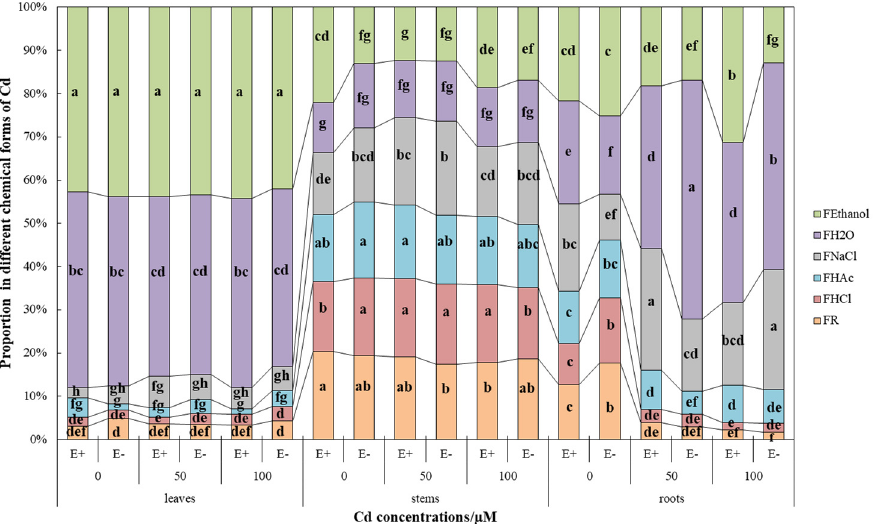
Figure 7. Distribution proportion of different chemical forms of Cd in the leaves, roots, and stems of Hordeum brevisublatum . F Ethanol : 80% ethanol extraction state; F H2O : deionized water extraction state, F NaCl : 1M NaCl extraction state, F HAc : 2% HAc extraction state, F HCl : 0.6 M HCl extraction state and F R : residual state. Lowercase letters (a–h) in the middle of bars indicate significant differences ( p < 0.05) of E+ and E − plants in di ff erent chemical forms under the di ff erent concentrations of CdCl 2 stress.